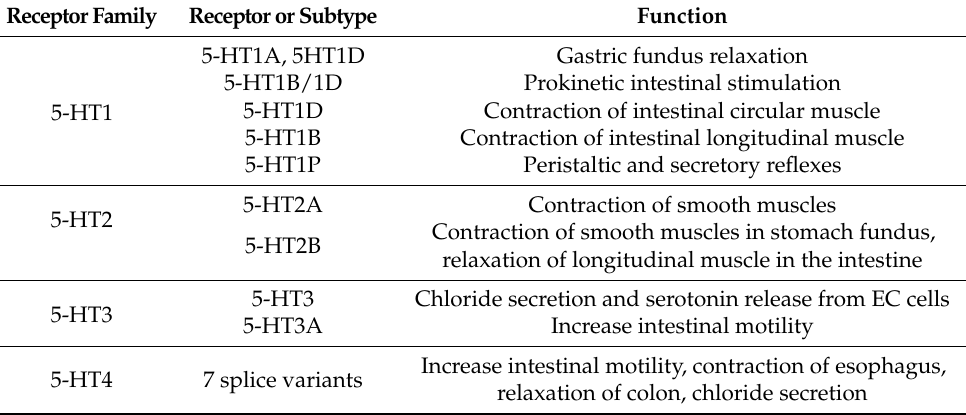
Table 1. Serotonin receptors and their functions in the gastrointestinal